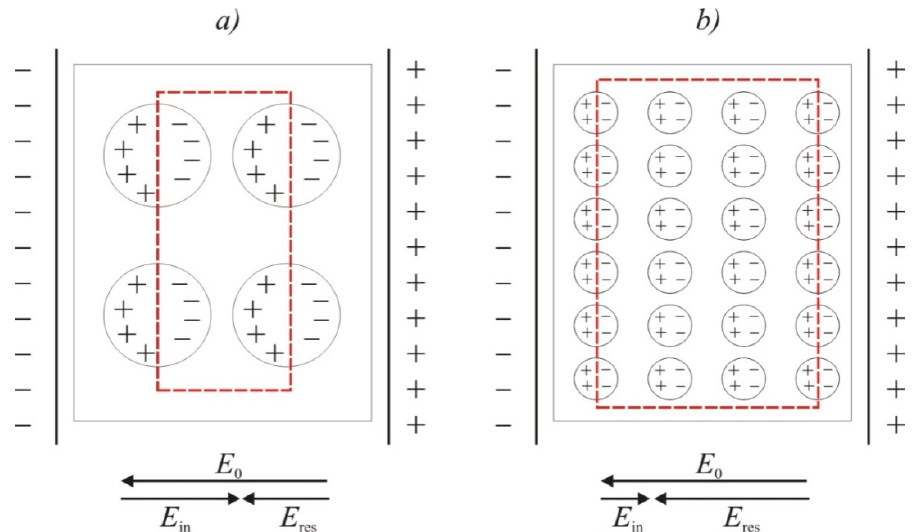
Figure 9. Schematic illustration of interfacial polarization of composites: ( a )